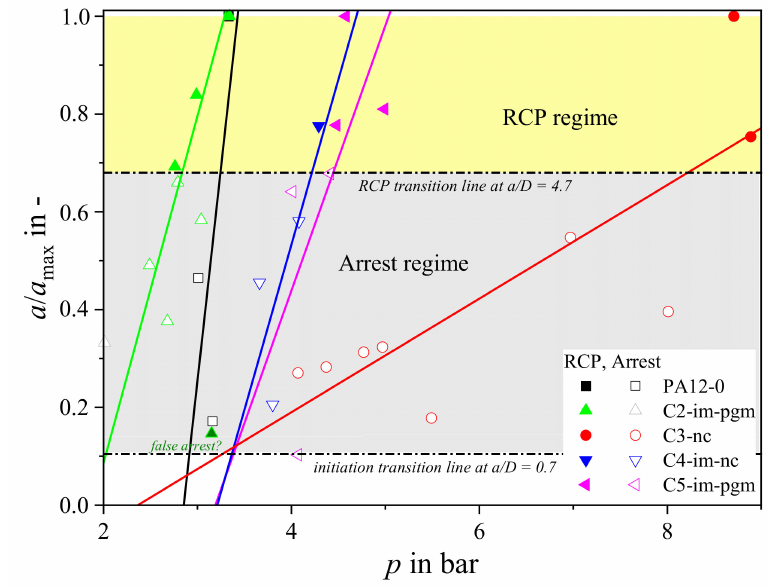
Figure 4. Modified evaluation of the critical pressure values of all grades at 0 ◦